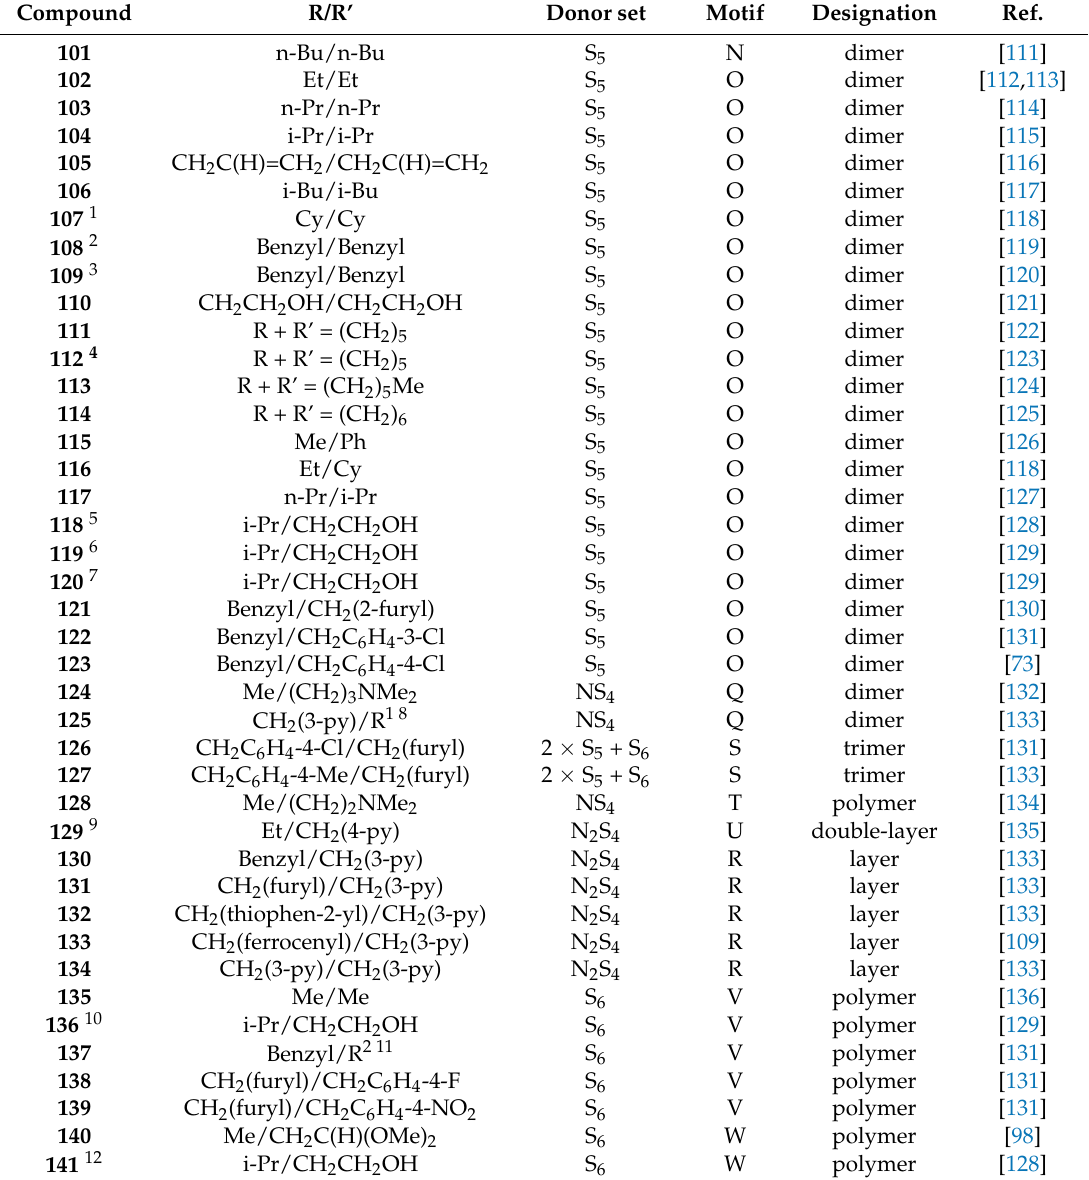
Table 4. Summary of the general features of Cd(S 2 CNRR’) 2 structures 101 – 141